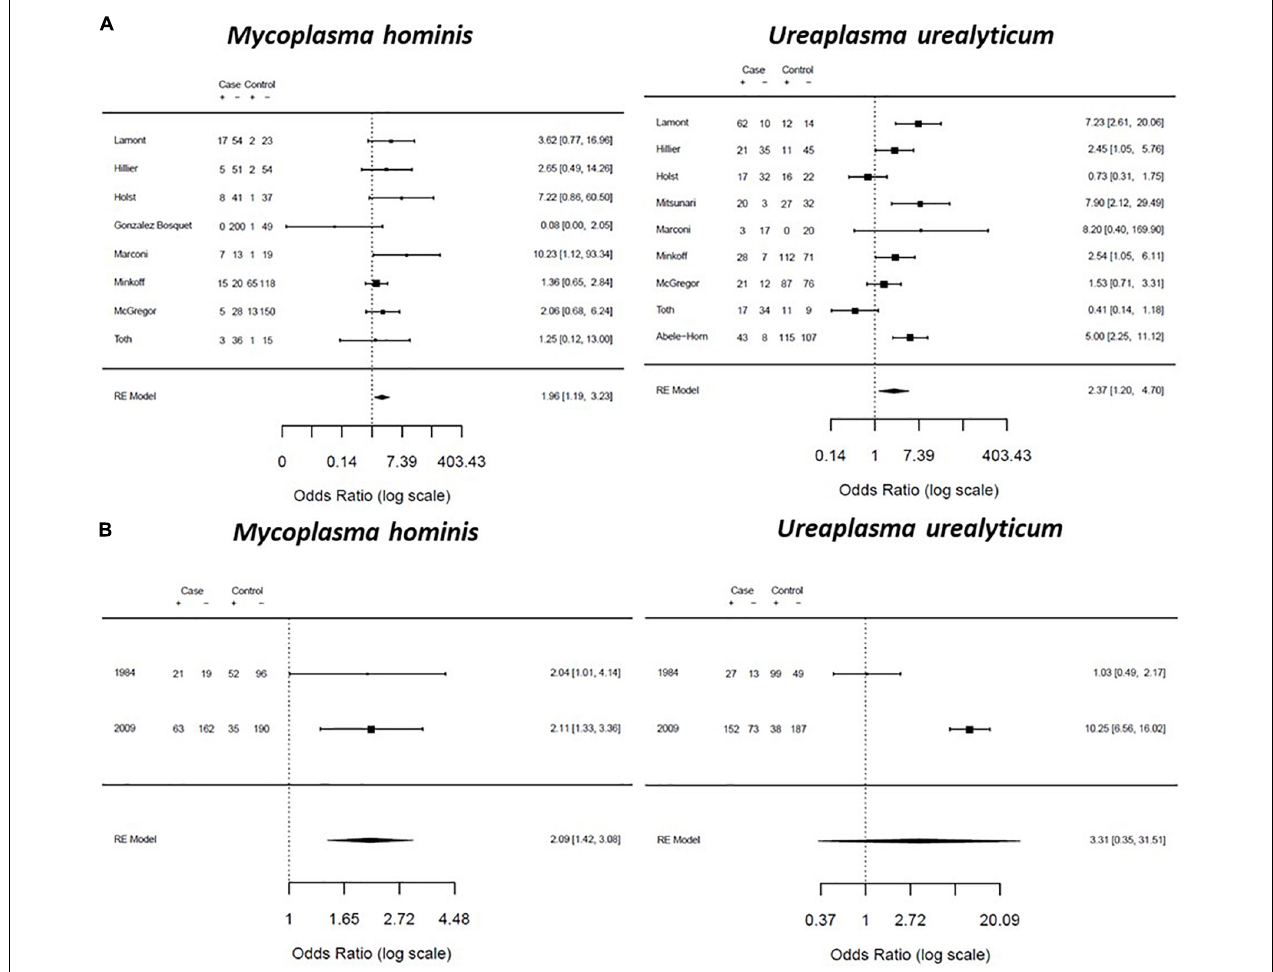
FIGURE 8 | Forest plot for the association between genital Mycoplasma infection and preterm labor (A) and preterm prelabor rupture of membranes (PPROM) (B) . Effect sizes were presented as pooled odds ratio with 95% confidence